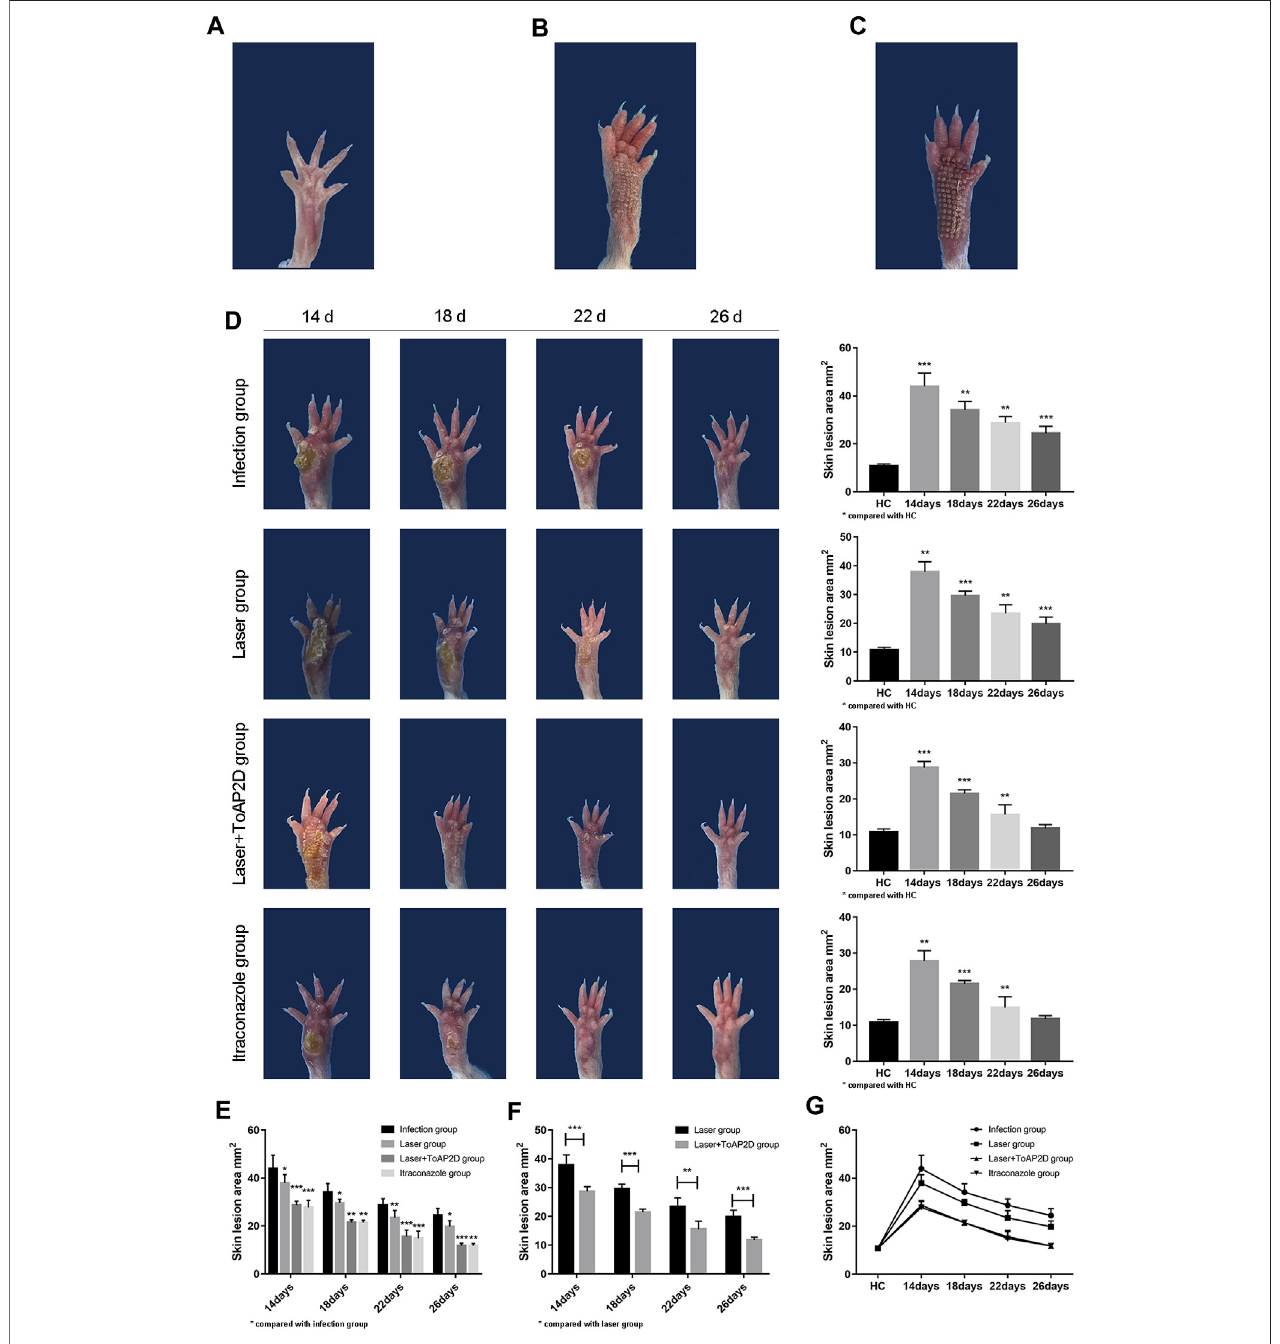
FIGURE5| Themiceskinlesionareacomparisonafterdifferenttreatments. (A) HCgroup. (B) Lasertreatment. (C) Laser+ToAP2Dtreatment. (D) Comparedwith theHC group, thefootpads ’ sizeafter differenttreatmentsfromDay14 to26. (E) Compared withtheinfection group,thefootpads ’ sizeinthe laser,laser+ToAP2D,and itraconazole group from Day14 to 26. (F) Compared with the laser group, the footpads ’ size in laser + ToAP2D group from Day14 to 26 (G) Analysis on the trend of the skin lesion area of all groups mice followed up time from Day14 to 26. * p < 0.05, ** p < 0.01, and *** p < 0.001 indicate statistical signi fi cance.